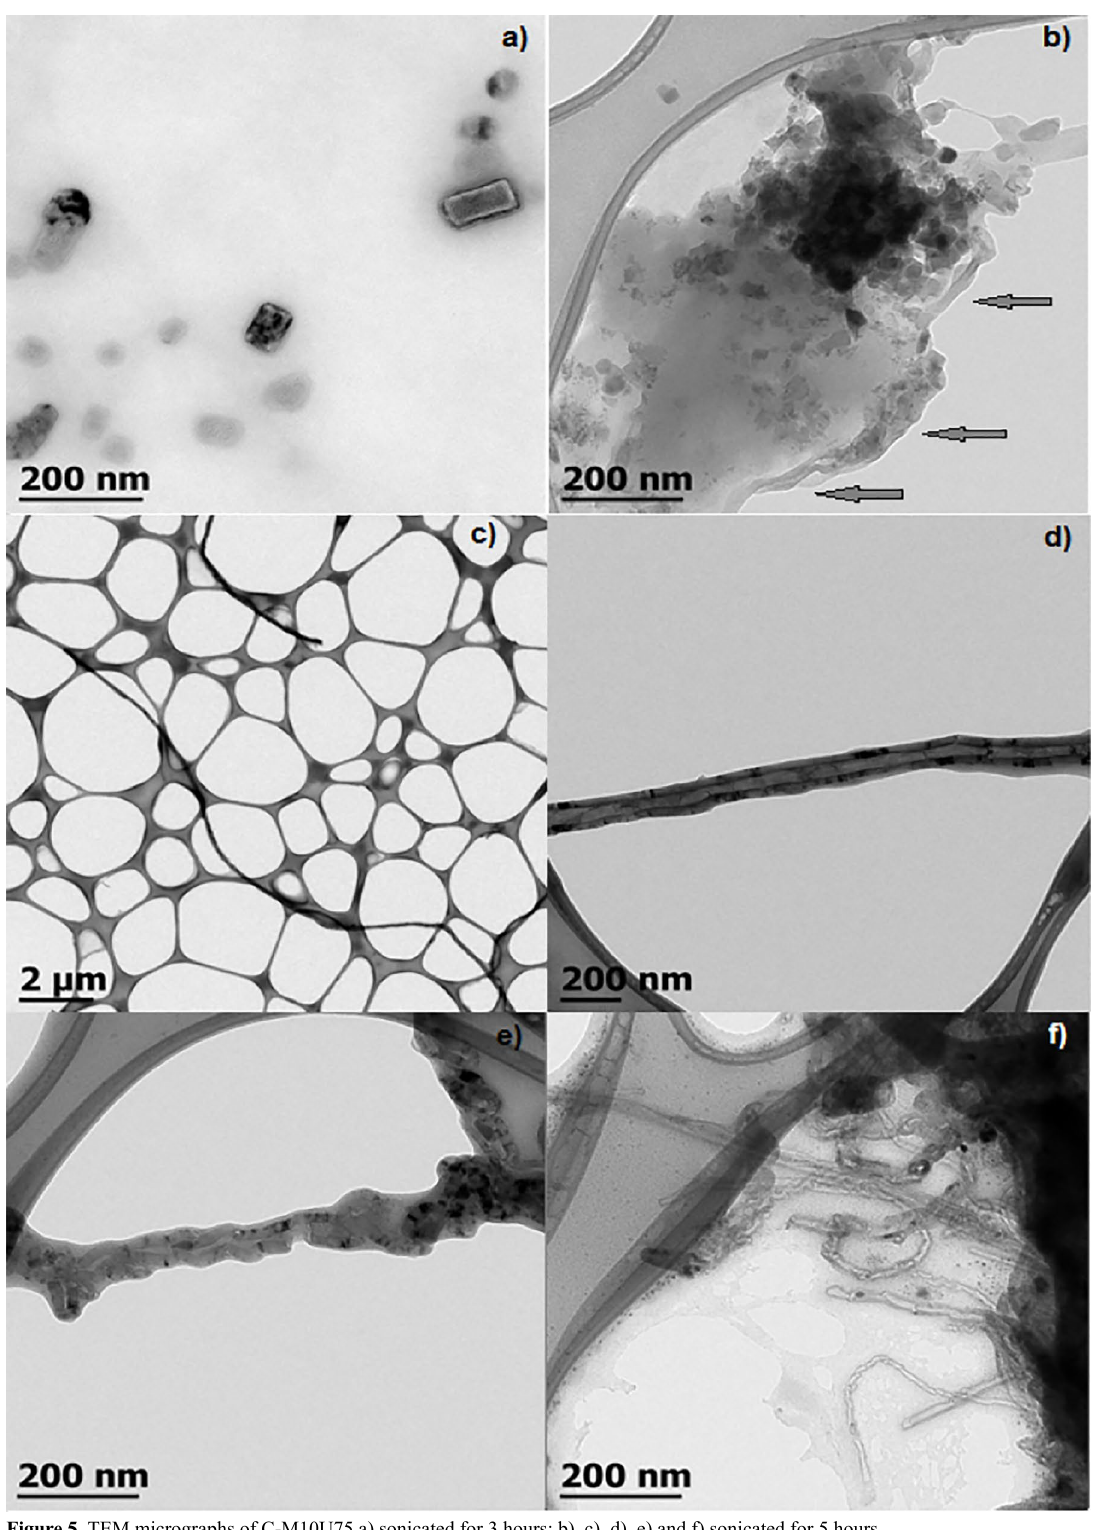
Figure 5. TEM micrographs of C-M10U75 a) sonicated for 3 hours; b), c), d), e) and f) sonicated for 5